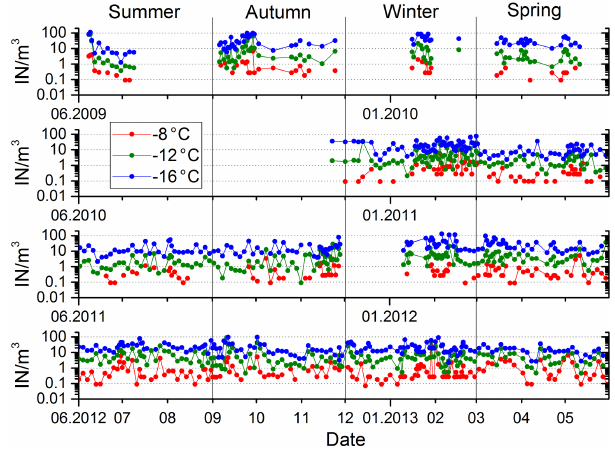
Figure 2. Four-year time series of ice nuclei concentration at three temperatures indicated in the